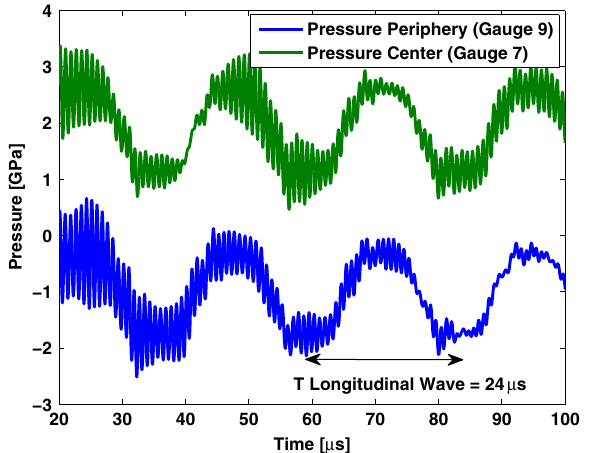
FIG. 7. Plot of the axial displacement at different longitudinal positions of the target core after proton pulse impact and under infinitely elastic material assumption. The plot clearly shows how the material of the target core longitudinally expands and contracts with a period of 24 μ